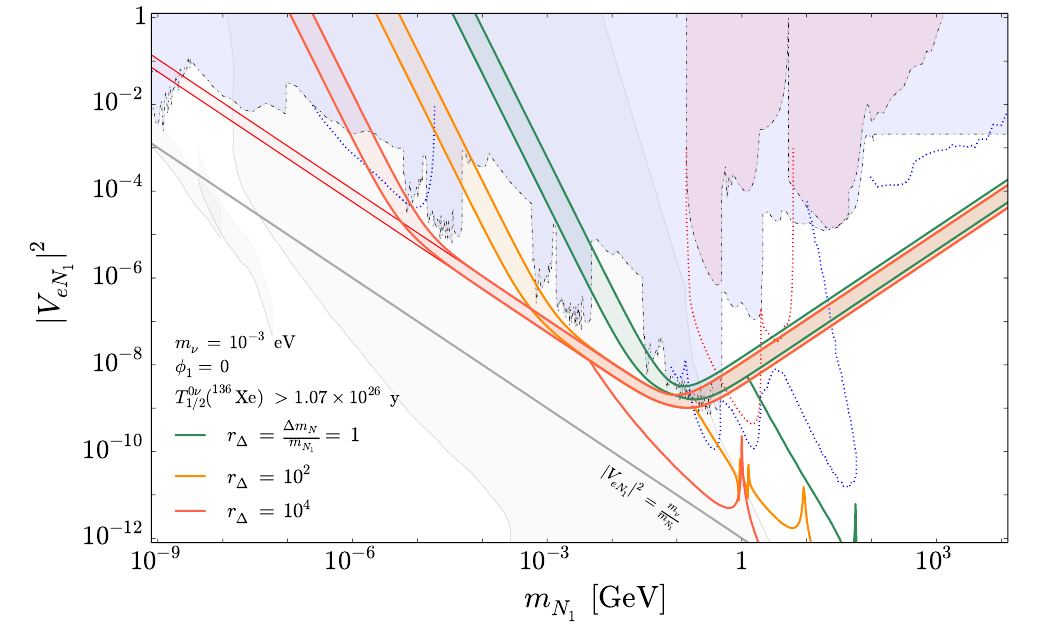
Figure 12 . Upper limits on the active-sterile mixing with N 1 for three values of the sterile neutrino mass splitting ratio r (cid:1) = (cid:1) m N 1. We show the limits for 136 Xe with shaded bands indicating the m N 1 (cid:21) respective uncertainties. The red curve highlights the limit in which 0 (cid:23)(cid:12)(cid:12) decay is driven by a single sterile neutrino. The curves sloping down to the lower right indicate the upper bounds by enforcing (cid:14)m 1 (cid:0) loop < 0 : 1 m (cid:23) . These constraints are compared with the current and future sensitivities of (cid:23) j j LNC (blue shaded/dotted) and LNV (red shaded/dotted) searches, cf. (cid:12)gures 6 and